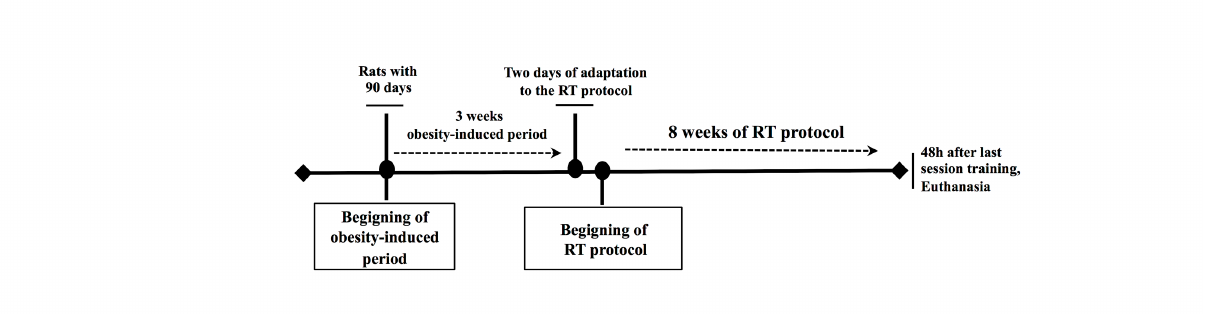
Figure 1 - Representation of the experimental design of the study.